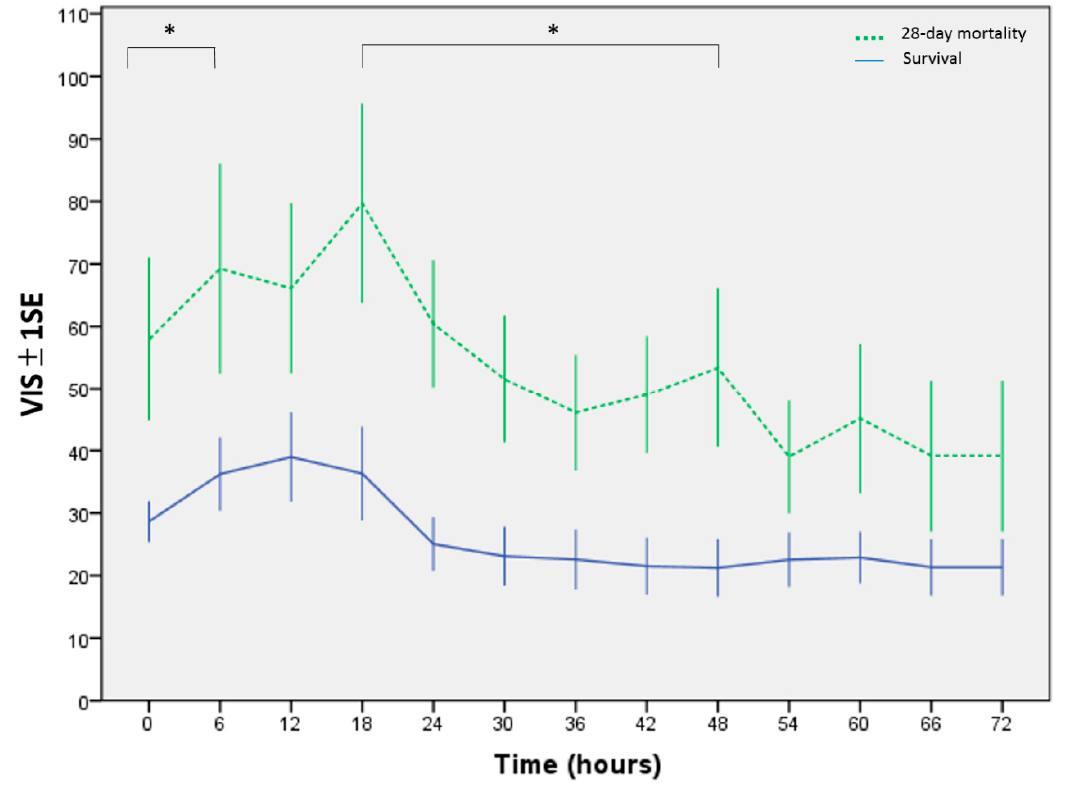
Figure 4. Serial vasoactive–inotropic score (VIS), measured at 6 h intervals. * Statistical significance was set at p < 0.05.